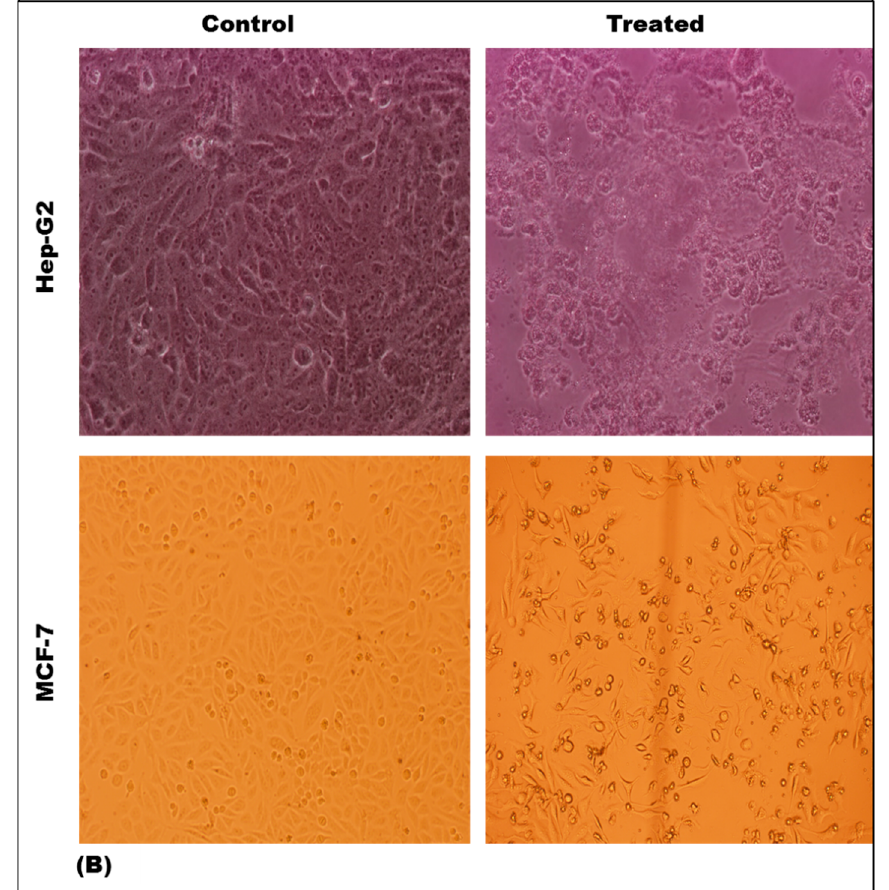
Figure 8. ( A ) Cell proliferation analysis by MTT assay. Different concentrations of EtOAc extract of Streptomyces sp. strain ess_amH1 were used to treat MCF-7 (breast cancer) and Hep-G2 (Hepatocar- cinoma cells) cancer cell lines. The means ± SE followed by different letters (a–e) within the same row are significantly different (Tukey’s test, p < 0.05). ( B ) Anticancer effect of with and without EtOAc extract of Streptomyces sp. strain ess_amH1.